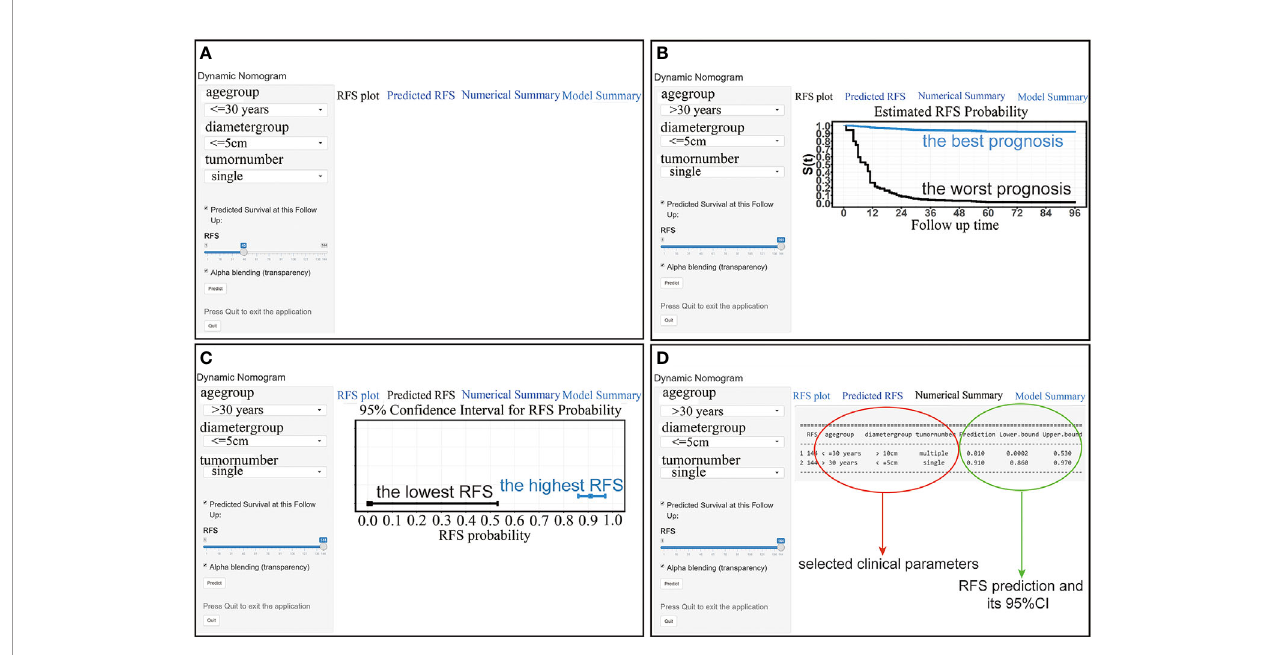
FIGURE 5 | (A) The interface of the web-based nomogram. (B) RFS curves for patients with the best (blue line) and worst (black line) prognosis. (C) The RFS probability and its 95% CI for patients with the best (blue line) and worst (black line) prognosis. (D) Numerical summary of the RFS